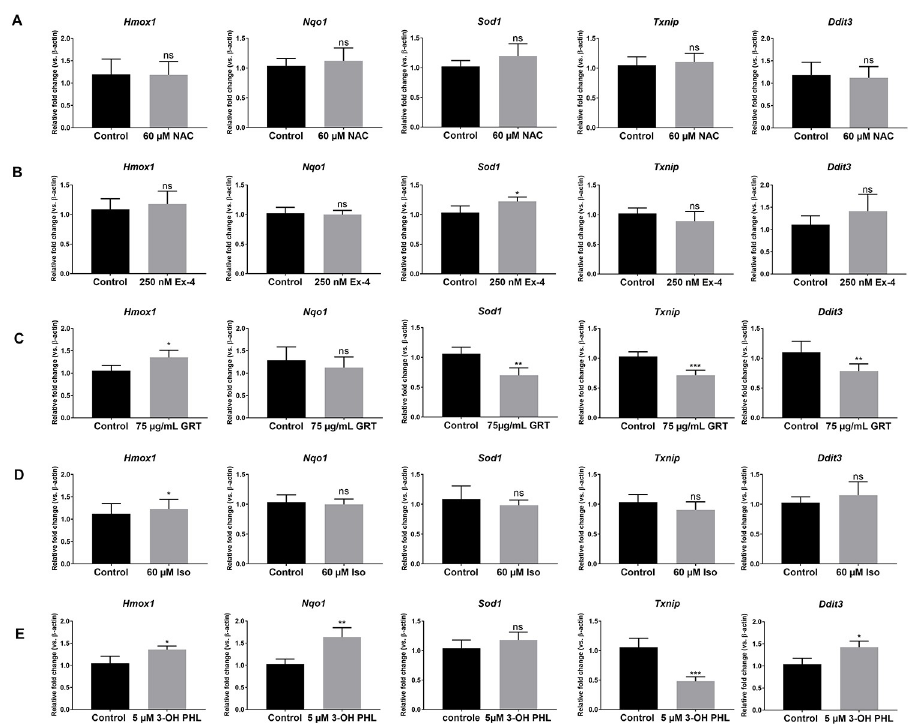
Fig 4. Gene expression analysis of INS1E β cells for antioxidant and apoptotic markers. INS1E β cells were treated with (A) 60 μ M NAC, (B) 250 nM exendin-4 (Ex-4), (C) 75 μ g/mL GRT, (D) 60 μ M isoorientin (Iso) and (E) 5 μ M 3-hydroxyphloretin (3-OH PHL). INS1E β cells were treated for 24 h before mRNA extraction. Relative mRNA fold change of antioxidant and apoptotic markers were normalized to β -actin . Differences between groups were analysed by paired one-tailed Student’s t -test, meanof independent plates ± SEM. NAC (n = 6), Exendin-4 (n = 6), GRT (n = 9), isoorientin (n = 6) and 3-OH PHL (n = 6). � p < 0.05, �� p < 0.01 and ��� p < 0.001. ns is non-significant.